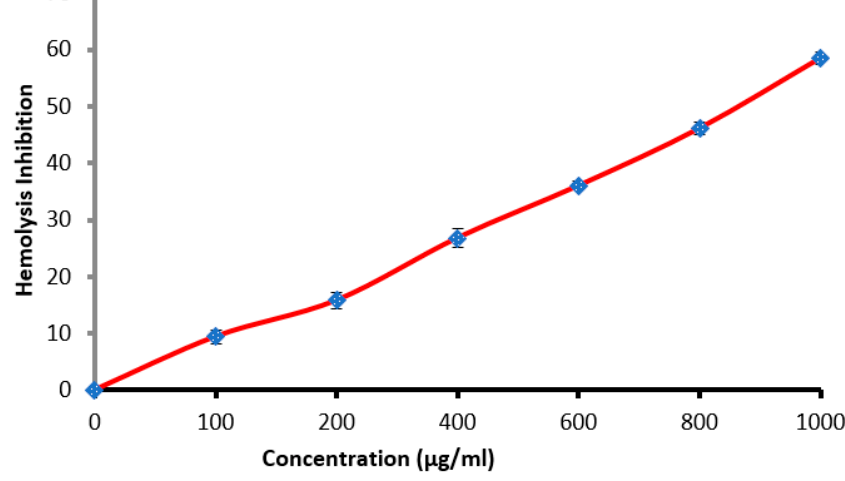
Figure 6. Hemolysis inhibition (%) at different concentration of